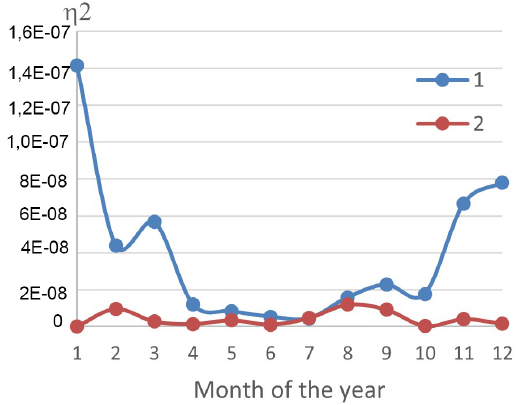
Figure 1. Influence of data series 1 and 2 over the year.